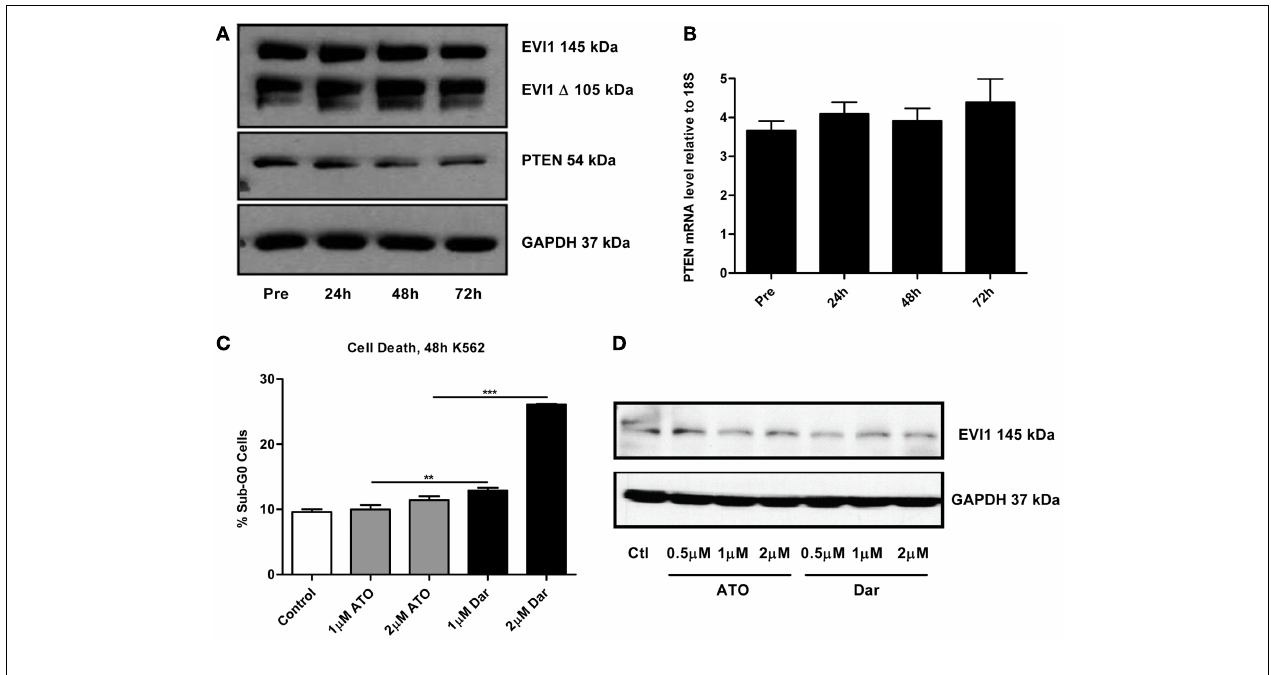
levels were found. (C) K562 chronic myeloid leukemia cells were treated for 48h with the indicated doses of arsenic trioxide (ATO) and darinaparsin (Dar) to assess sensitivity to arsenicals. Cell death was measured as the percentage of cells with sub-G 0 DNA content. Error bars indicate SEM. (D) Western blot of EVI1 in K562 cells treated for 24h with the indicated doses of ATO and darinaparsin (Dar). GAPDH is included as a loading control.